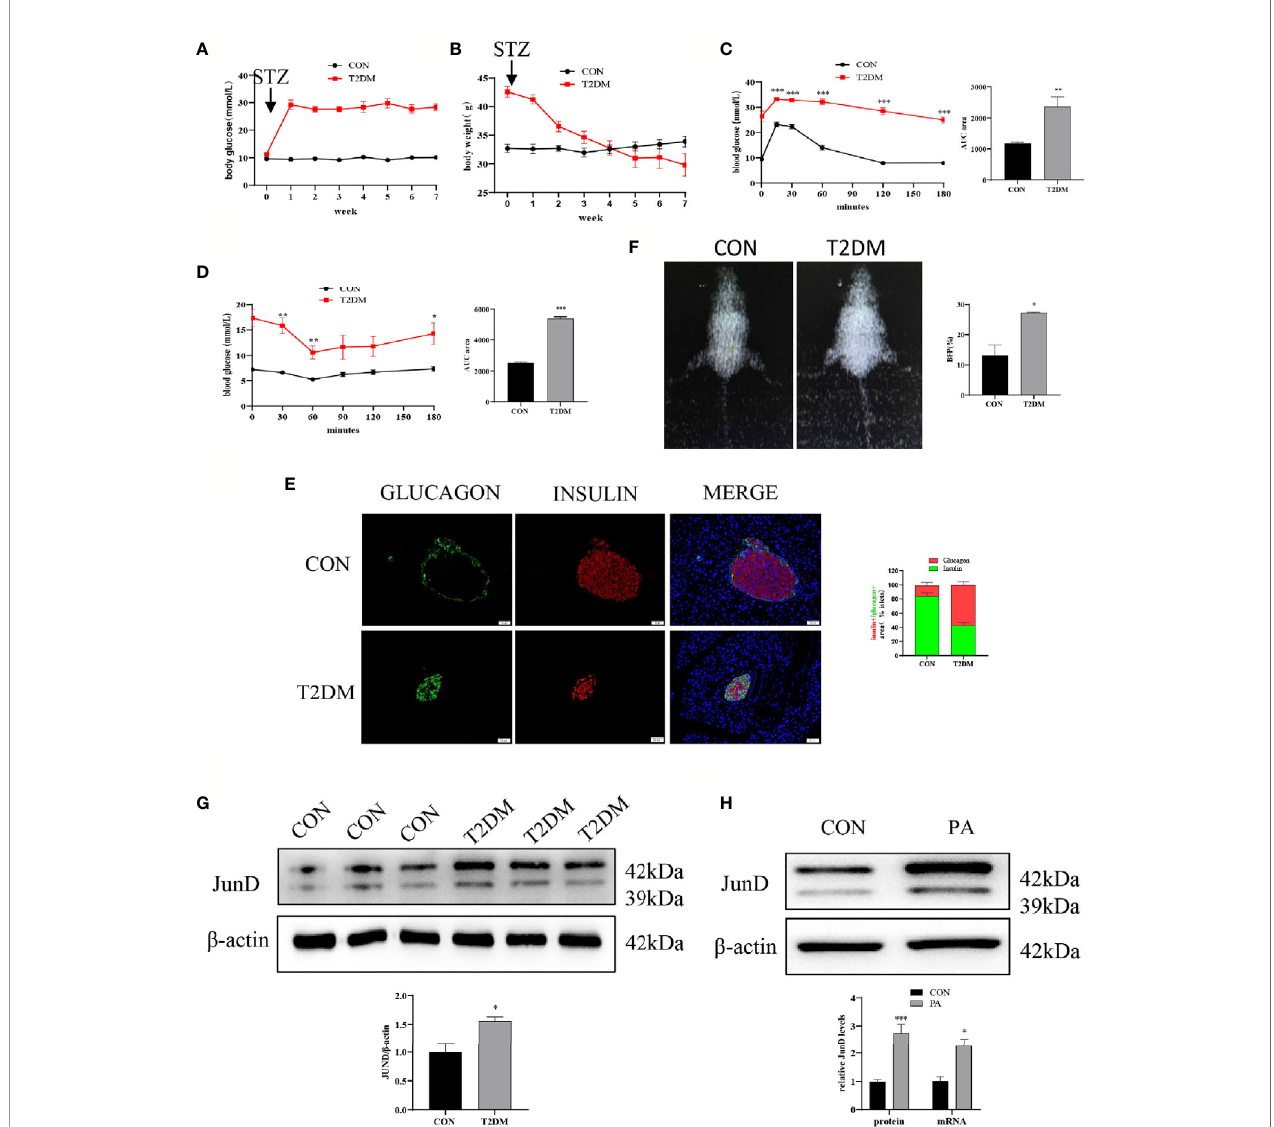
FIGURE 1 | JunD was activated in islets of T2DM mice and PA-stimulated INS-1 cells. Blood glucose (A) and body weights (B) of T2DM mice compared with control mice before or after STZ injection. Intraperitoneal glucose tolerance test (IPGTT) (C) and intraperitoneal insulin tolerance test (IPITT) (D) were performed 1 week after the establishment of the T2DM mice model, and the area under curve (AUC) was also calculated. (E) The representative dual-energy X-ray absorptiometry image showed the body fat of the mice and the comparison of body fat percent (BFP%). (F) The representative immuno fl uorescence images of pancreases stained with insulin and glucagon, and the percentage immune-positive area of the islet insulin and glucagon, scale bar=20 m m. (G) The protein expression of JunD in islets was detected by Western blot. (H) The protein mRNA levels of JunD in PA-stimulated INS-1 cells. Data are expressed as the mean ± SEM. *p < 0.05; **p <0.01; ***p < 0.001 (compared with control